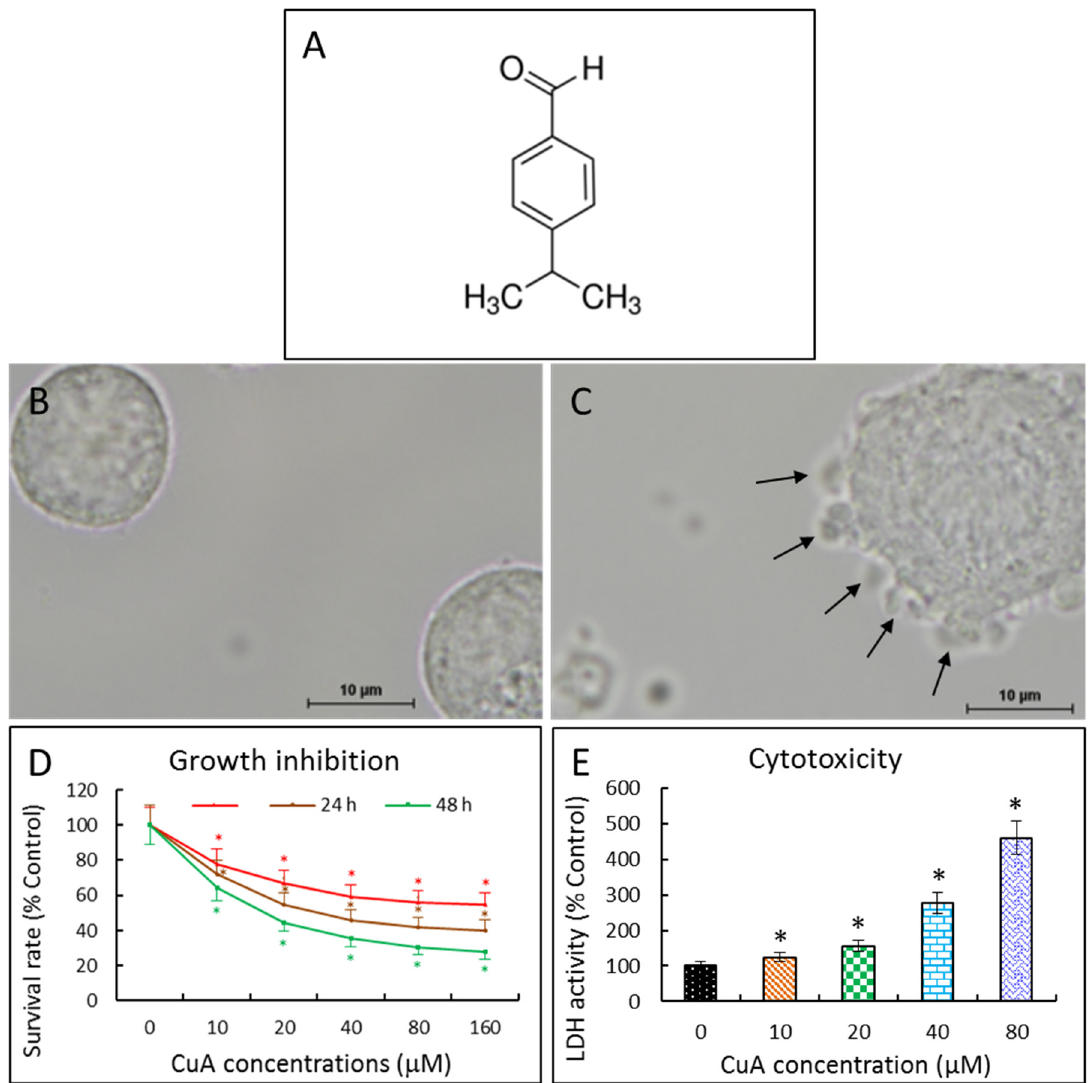
Figure 1. Cuminaldehyde’s chemical structure and effects on cellular morphology, proliferation, as well as lactate dehydrogenase releasing in human colorectal COLO 205 cells. ( A ) Chemical structure; ( B ) and ( C ) Cuminaldehyde’s effect on cellular morphology; Cells were treated without ( B ) and with 20 μ M ( C ) cuminaldehyde for 48 h. Cell detachment, shrinkage, and blebbing of plasma membrane (arrows) were found when the cells were incubated with 20 μ M of cuminaldehyde; ( D ) Cuminaldehyde’s effect on growth. Human colorectal COLO 205 cells were treated with cuminaldehyde at the specified circumstances. Proliferation suppressive effect was determined using the XTT test; ( E ) Cuminaldehyde’s effect on the lactate dehydrogenase releasing in the cells. The supernatant was gathered after 48 h of incubation with the indicated cuminaldehyde concentrations. Absorptions of light were determined by a spectrophotometer (Tecan infinite M200, Tecan, Männedorf, Switzerland). Results are shown by means plus/minus standard error of the mean, n equal to 3. *, Statistically significant ( p less than 0.05) from the control group. CuA, cuminaldehyde.